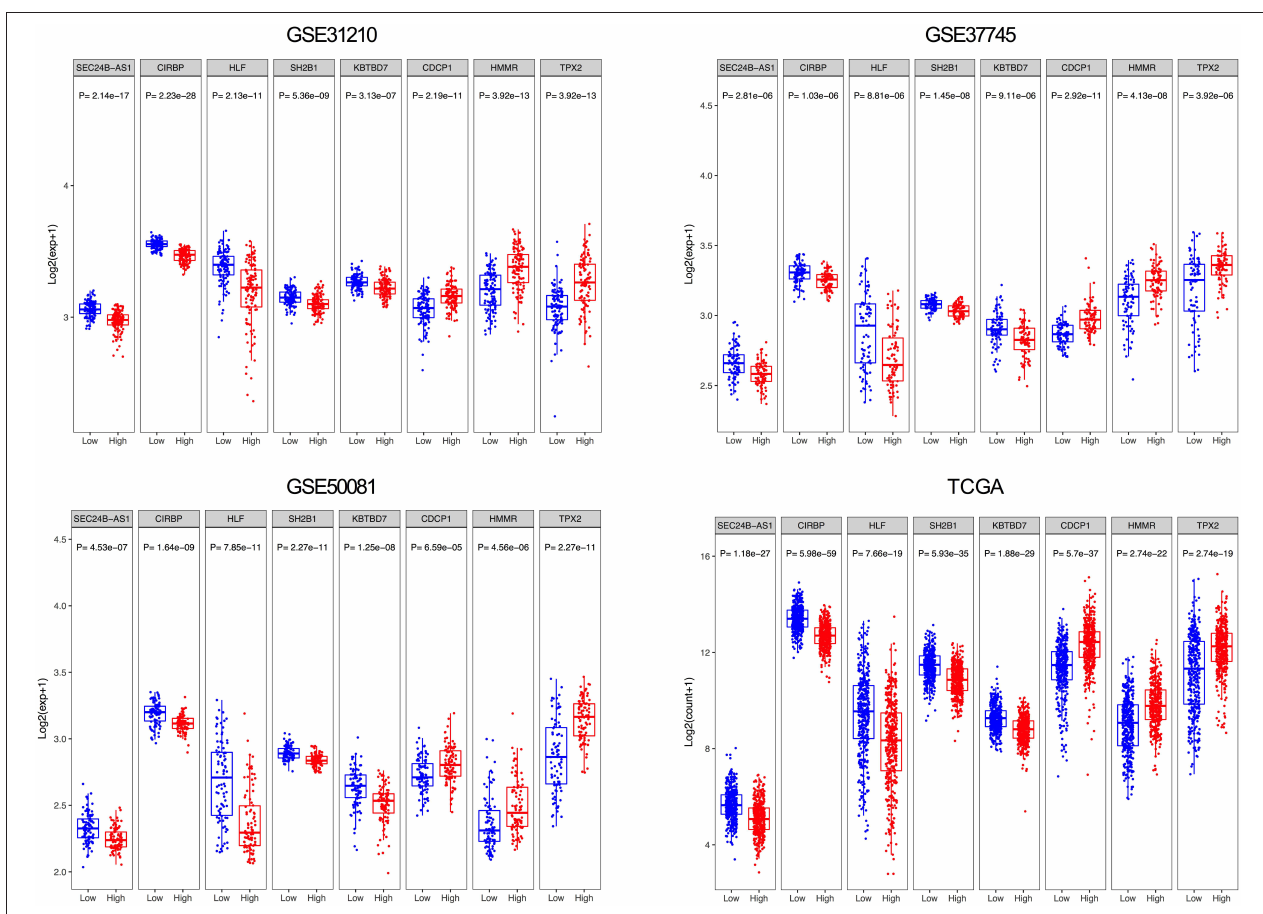
FIGURE 4 | Box plot visualization of the expression levels of the 8 genes in the risk